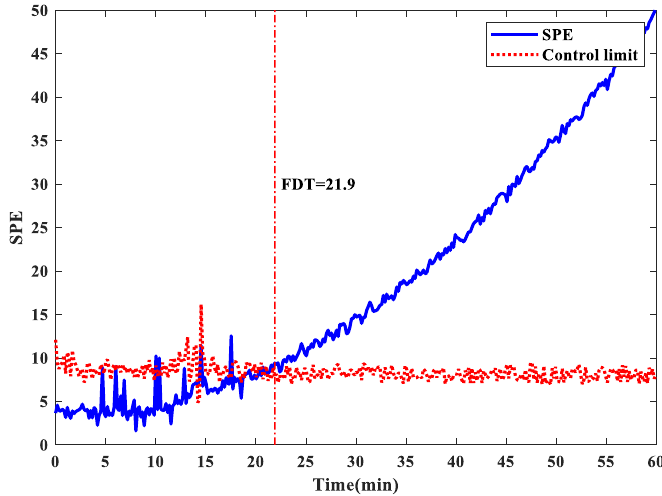
Figure 8. SPE fault monitoring chart of F4 based on MI-MPCA.